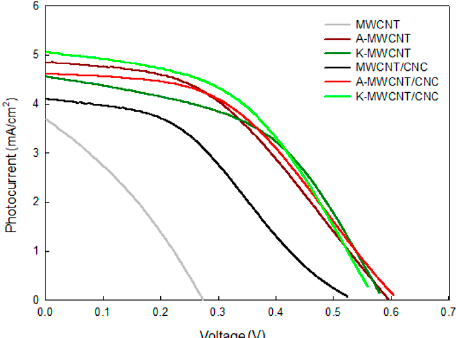
Figure 7. Photocurrent–voltage ( J – V ) curve characteristics of the DSSCs with various counter electrodes.